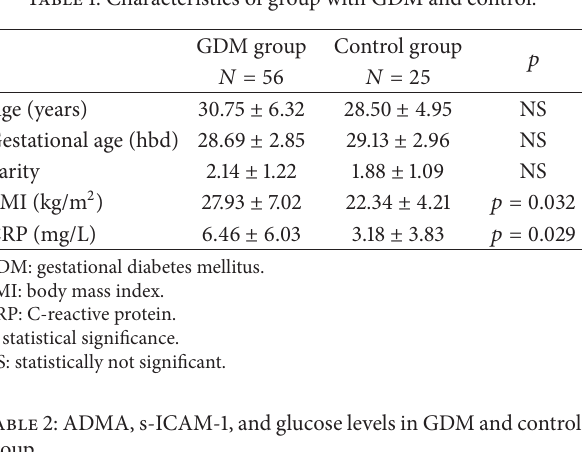
Table 2: ADMA, s-ICAM-1, and glucose levels in GDM and control group. GDM group Control group 𝑝 𝑁 = 56 𝑁 = 25